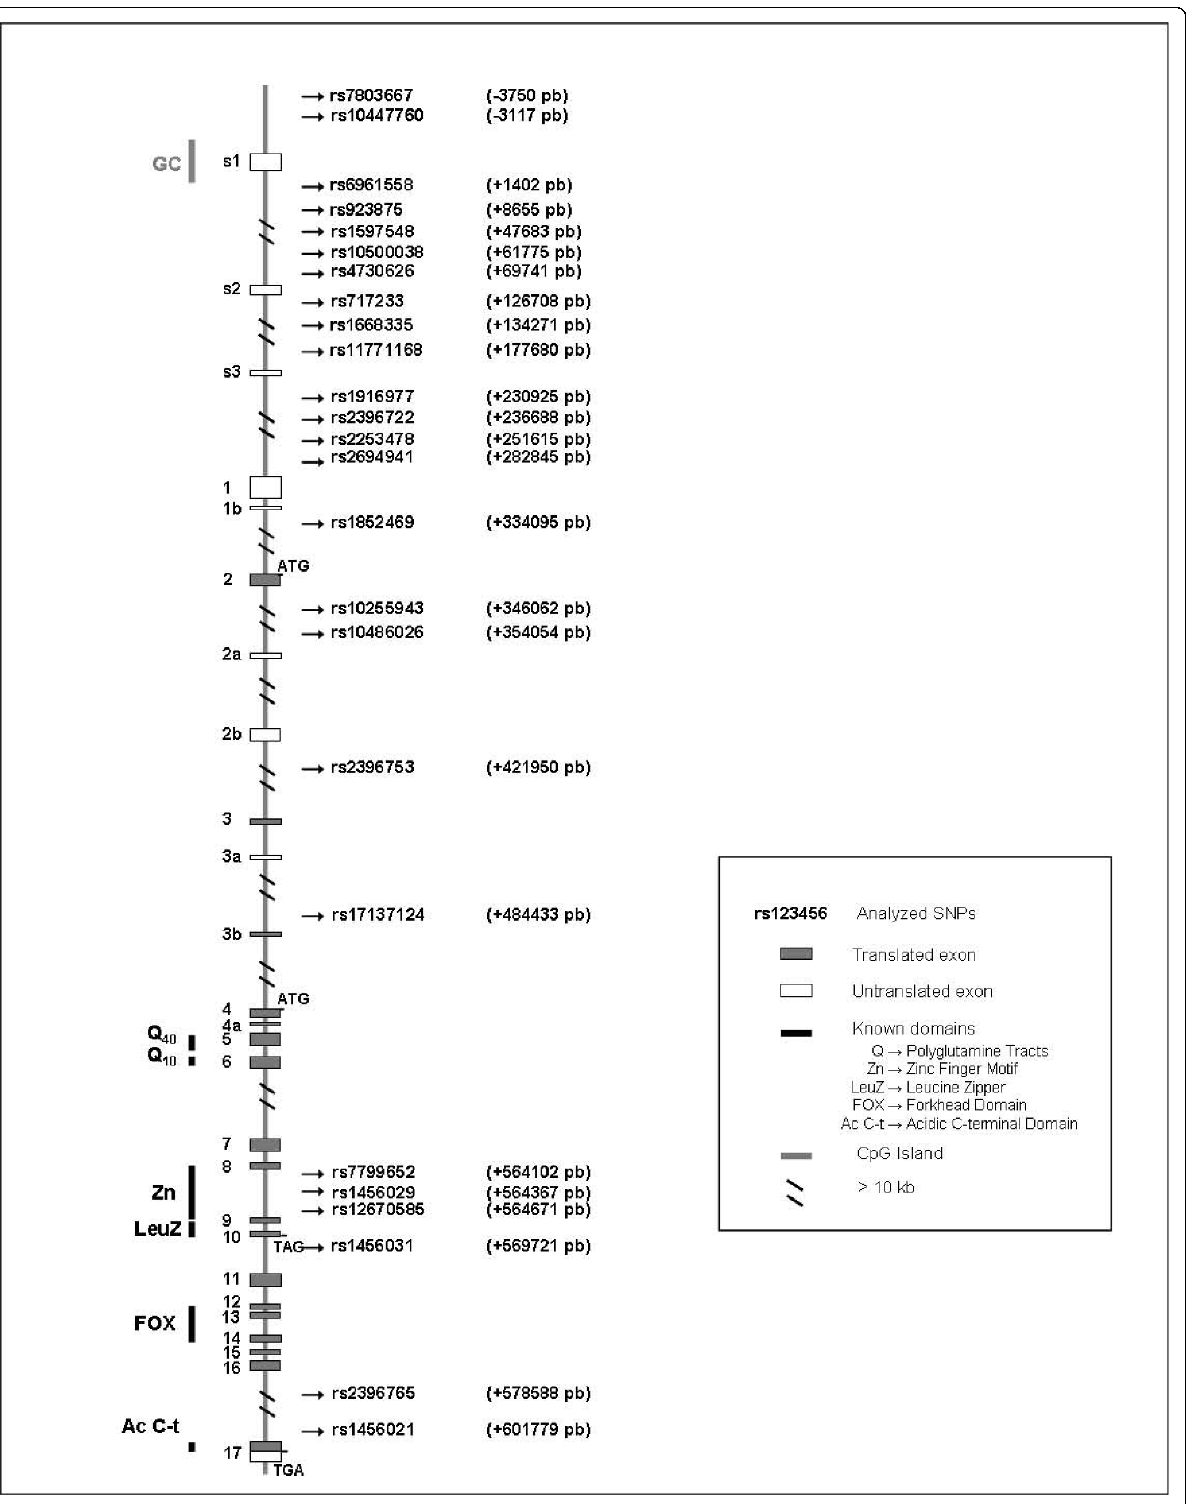
Figure 1 Structure of FOXP2 gene . Hash marks indicate introns longer than 50 kb. Arrows indicate positions of all single nucleotide polymorphisms (SNPs) analyzed in this study: arrows indicate SNPs polymorphic in our sample. Distances of SNPs to +1 site (5 ’ end of s1 exon) are shown in